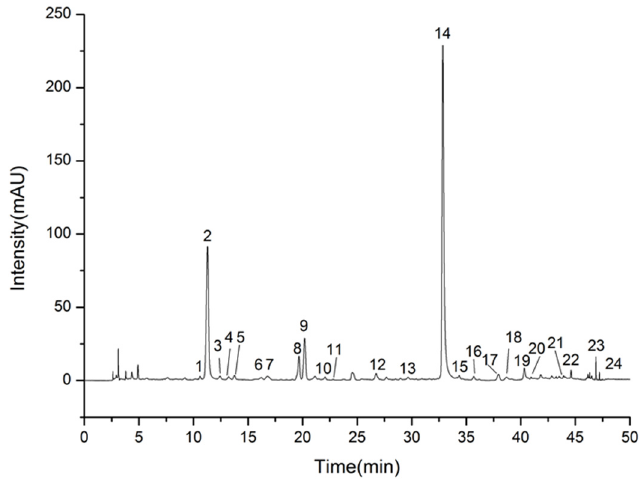
Figure 1. Typical LC chromatograms of sample